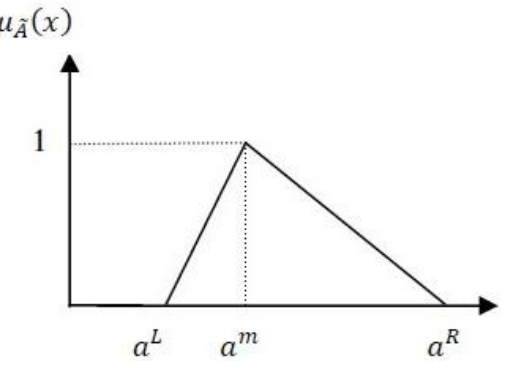
Figure 1. Triangular possibility distribution of fuzzy number 𝐴̃ = (𝑎 𝐿 , 𝑎 𝑚 , 𝑎 𝑅 )